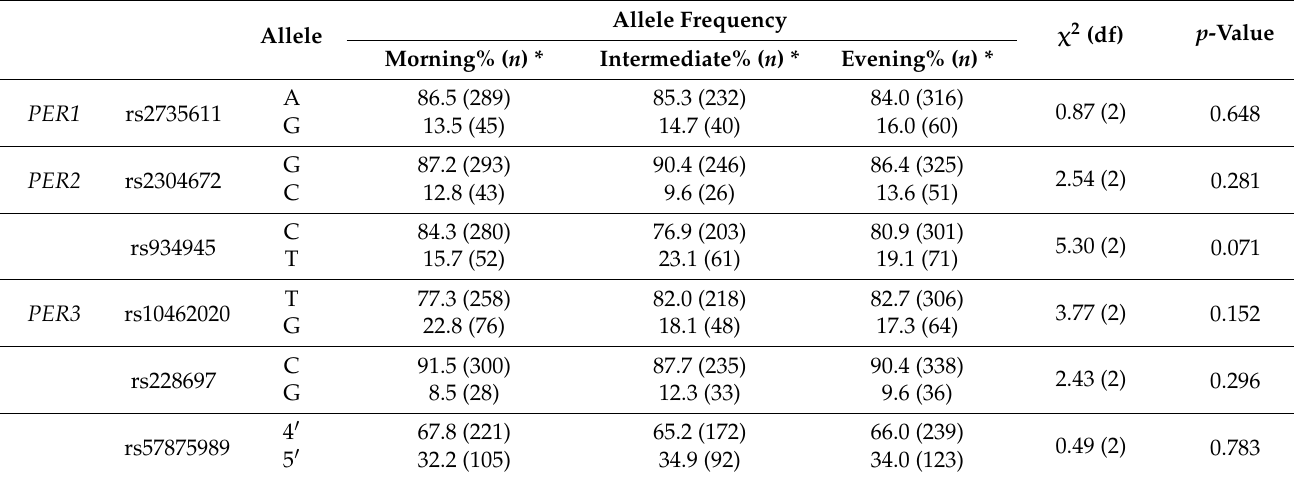
Table 4. Allele frequency of PER1 , PER2 , and PER3 genetic variants in relation to diurnal preference in cluster headache